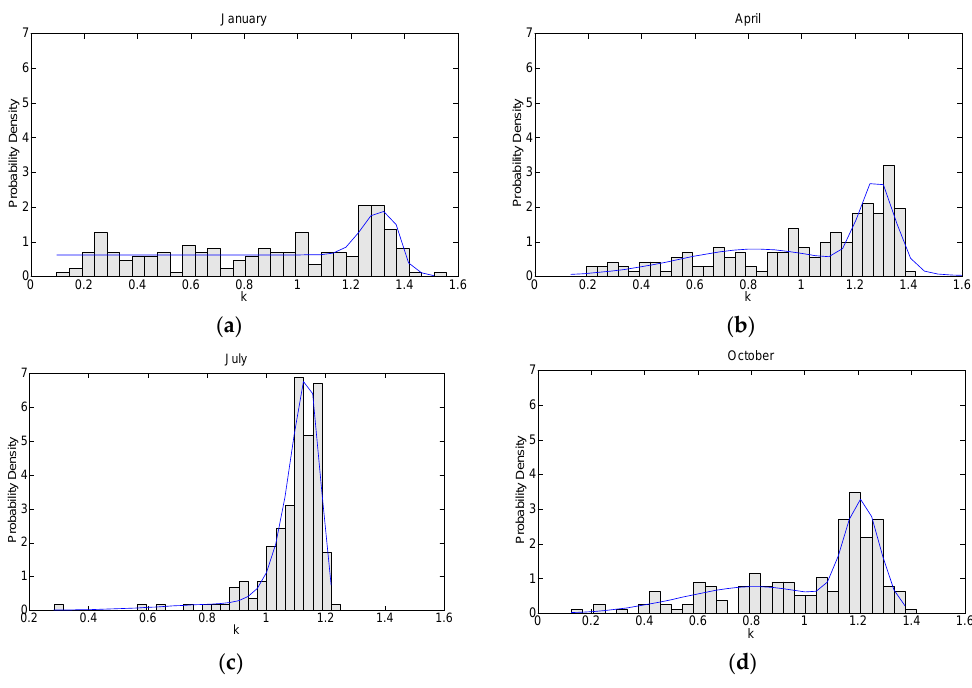
Figure 5. Discrete probability distributions of 𝐾 𝑚 and their fitting probability density functions (pdfs) with reference to the months of ( a ) January; ( b ) April; ( c ) July; and ( d ) October.